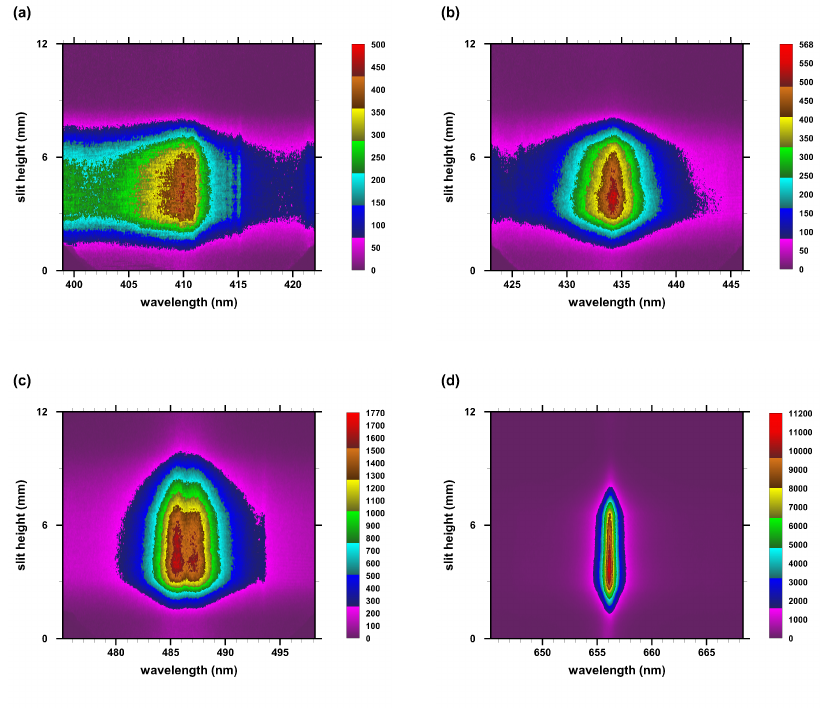
Figure 2. Recorded Balmer-series hydrogen lines at 1.5- µ s time delay, 0.025- µ s gate. ( a ) H δ , ( b ) H γ , ( c ) H β , and ( d ) H α